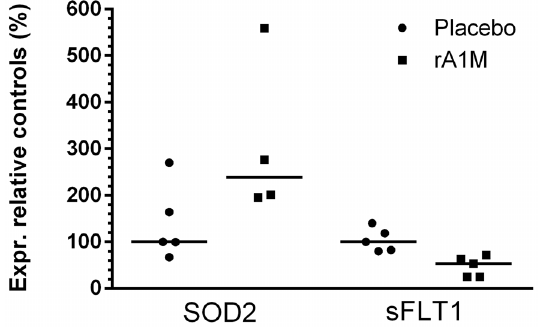
Figure 12. The effects of A1M-treatment on gene expression in white blood cells, placenta and kidney tissue. The A1M treatment regulates transcription of SOD2 and s-Flt1 genes in white blood cells in N the starved pregnant ewes. The gene expression in starved ewes ) or A1M ( & ) were analyzed. The gene injected with placebo ( expression data was normalized to b -actin. The median value of the starved + placebo group was set to 100% and the results are expressed as percentage of the median value. The A1M treatment caused significant increase in SOD2 mRNA expression in white blood cells (p= , 0.043) and a decreased expression of s-Flt1 mRNA (p= , 0.012). All other investigated genes were unaffected by A1M treatment.